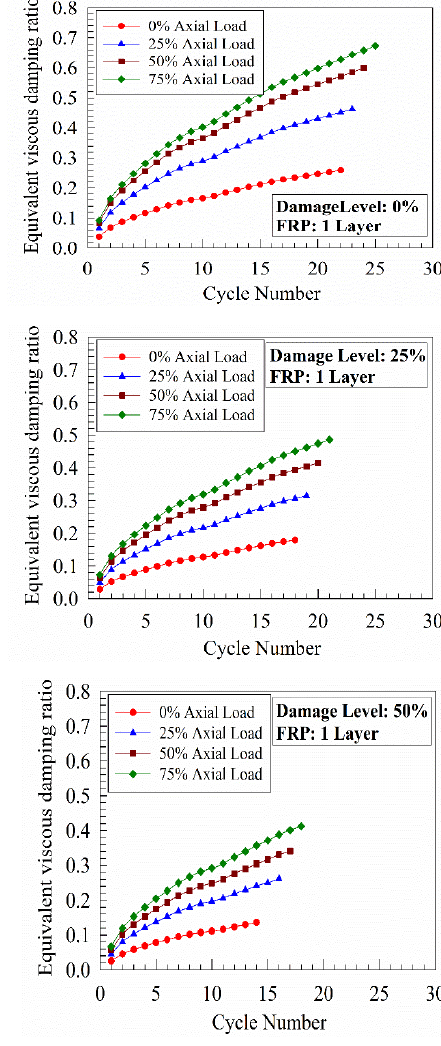
Figure 15. Stiffness degradation behavior.